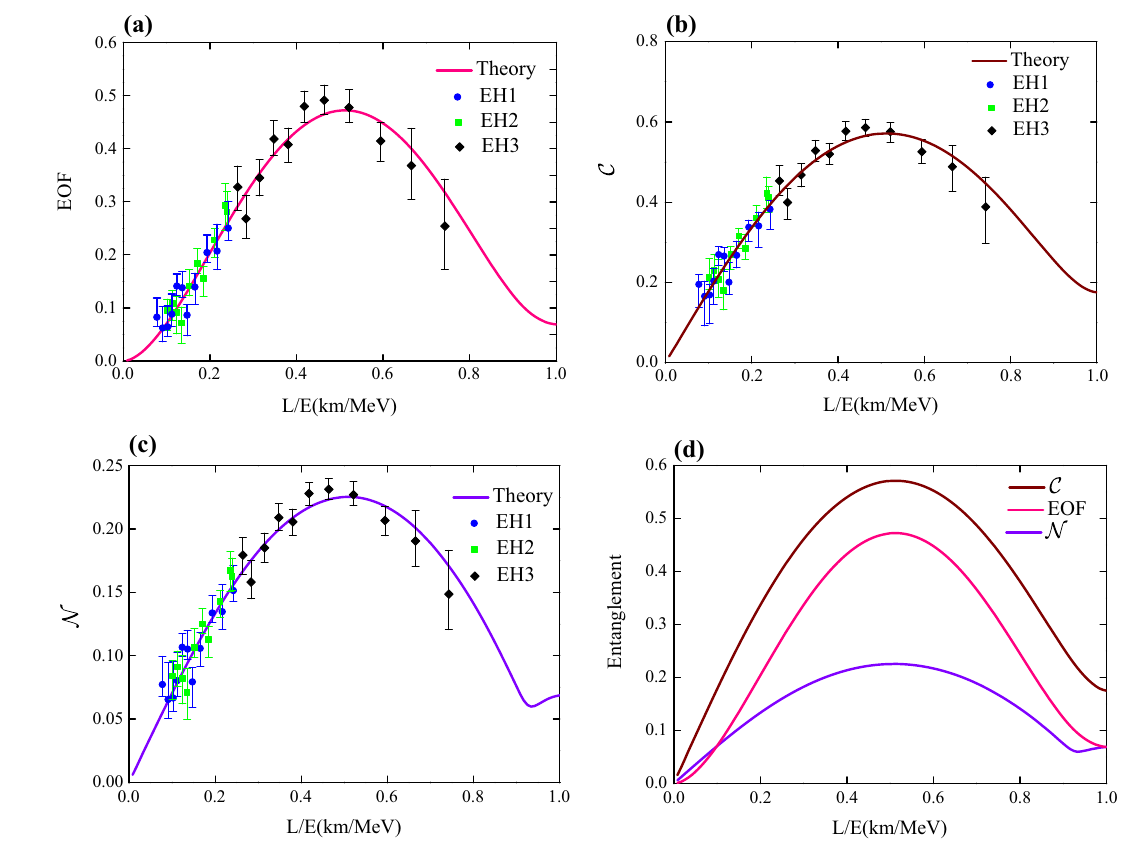
Fig. 2 Negativity ( N ) and entanglement of formation (EOF) and con- currence ( C ) as a function of the distance traveled per energy L / E with an initial electron flavor state. a The pink line denotes the theoretical EOF expressed by Eq. (22); b The wine line denotes the theoretical con- currence in Eq. (24). c The violet line denotes the theoretical negativity